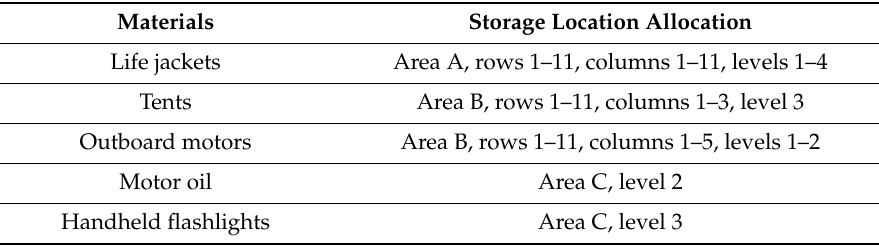
Table 7. Simplified storage location allocation